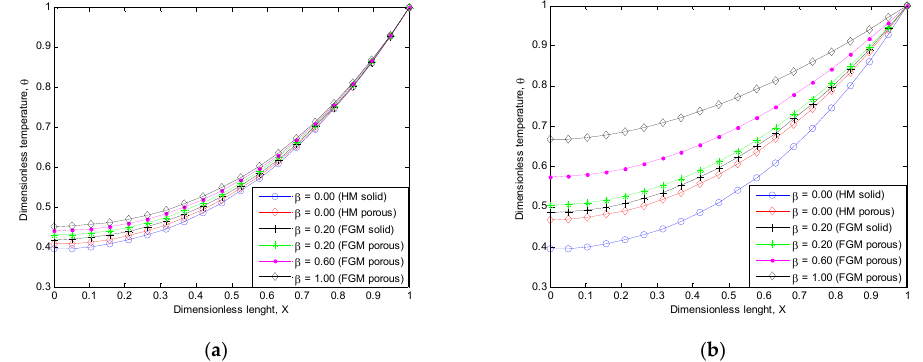
Figure 6. Fin dimensionless temperature profile for the varying thermogeometric parameter: ( a ) linear ‐ law function and ( b ) power ‐ law function.